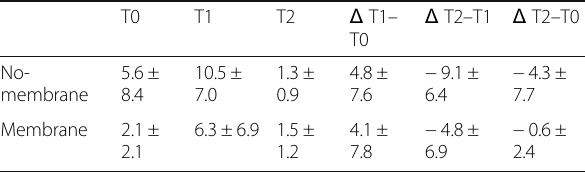
Δ T2 – T1 Δ T2 – T0 T0